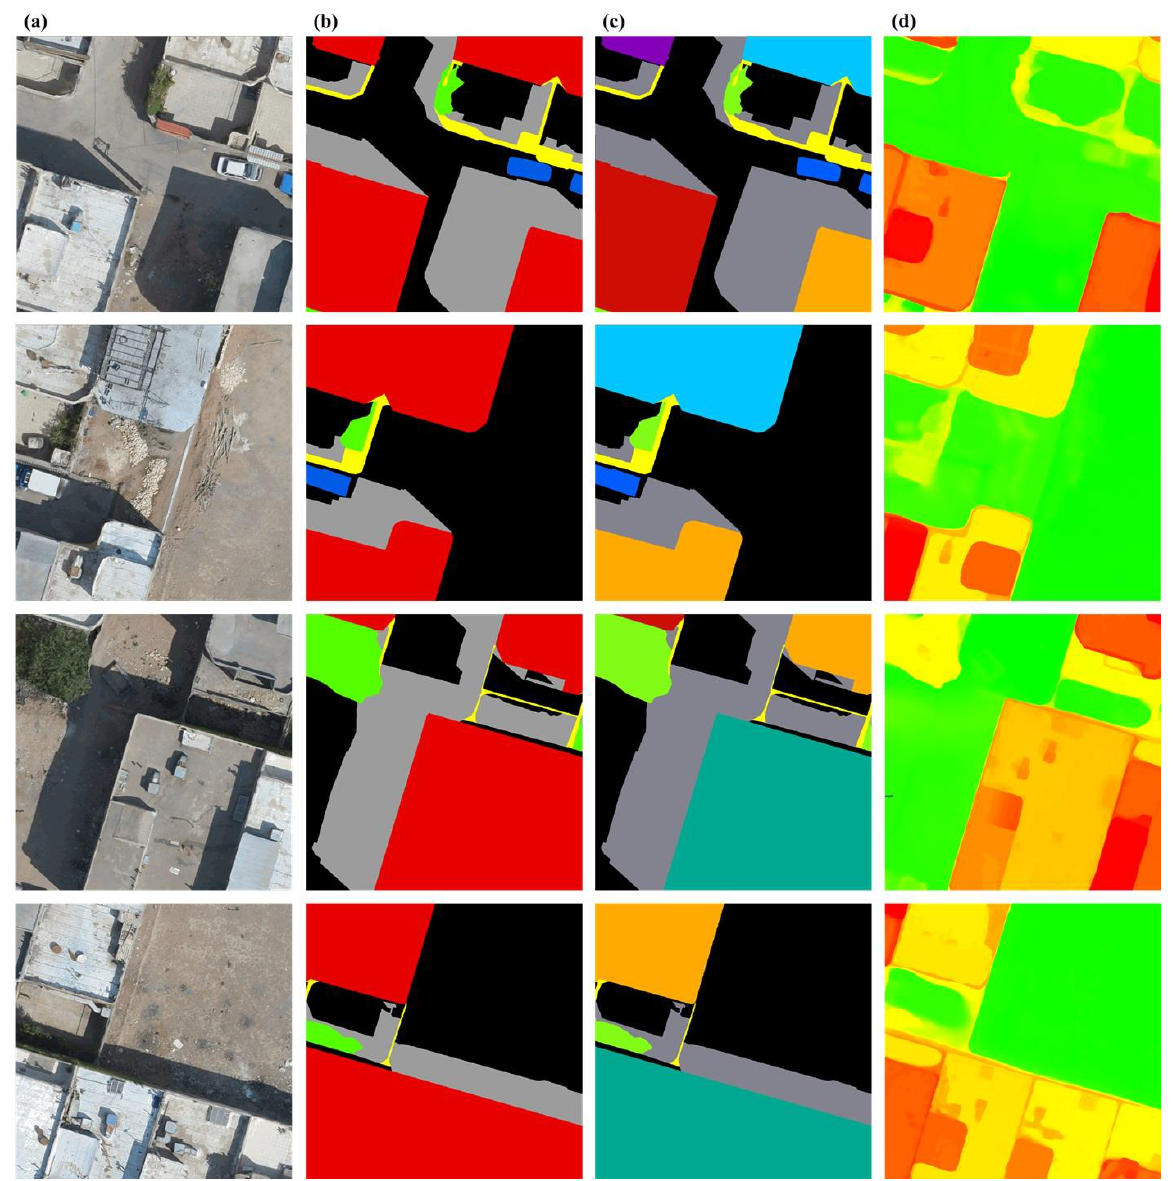
Figure 3. Sample screenshot of the proposed dataset for scene understanding with (a) RGB orthophoto, (b) semantic